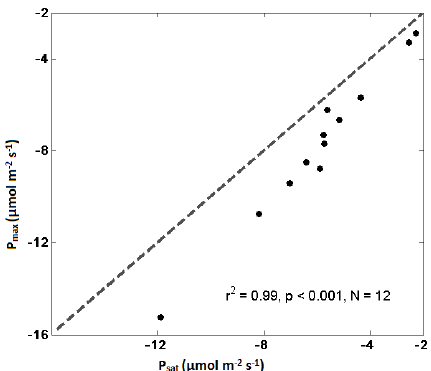
Figure B3. Correlations between Eq. (1) (Falge et al., 2001) and (2) (Ruimy et al., 1995) using photosynthesis at light saturation. Potential photosynthesis at light saturation ( P sat ) was calculated as the sum of F csat and R d in Eq. (1) (Falge et al., 2001; Lindroth et al., 2007) and was estimated by P max in Eq. (2) (Frolking et al., 1998; Laurila et al., 2001; Ruimy et al., 1995) based on the 12 sites in this study. Broken line represents the 1:1 line.